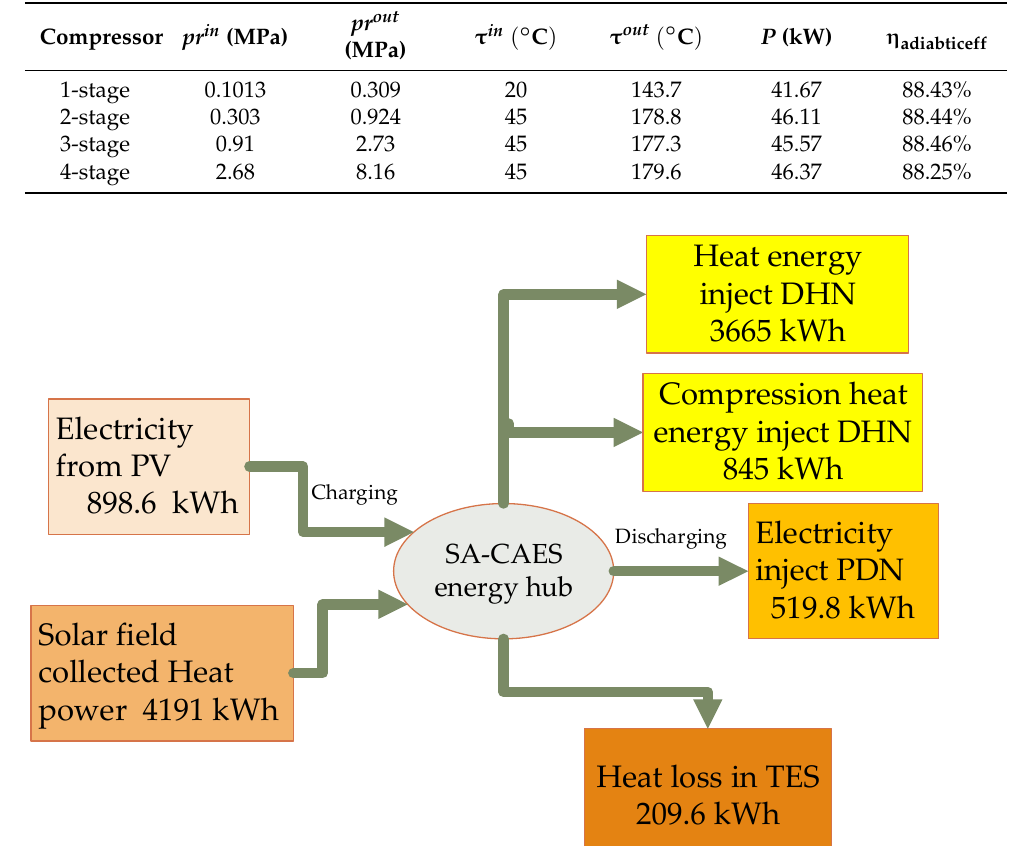
Table 2. The parameters of the compressor under the design operation.